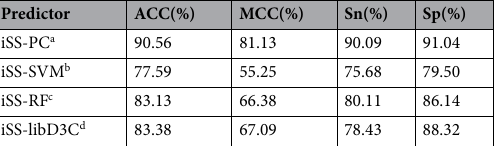
Table 5. The 5-fold cross-validation test results obtained from different classification algorithms with the same feature extraction method on benchmark data-set only containing splice donor site sequences. a The predictor with SAE proposed in this paper. b The predictor with SVM created in WEKA with the default parameters. c The predictor with Random Forest (RF) created in WEKA. d The predictor with an ensemble classifier libD3C.